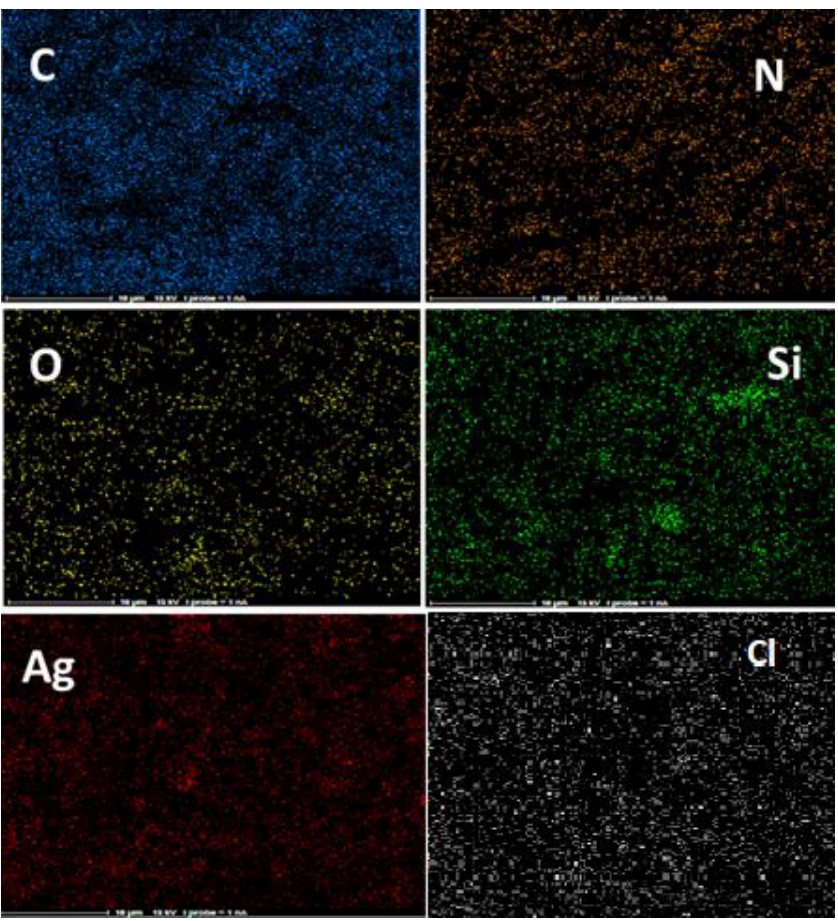
Figure 2. Elemental mapping of catalyst.